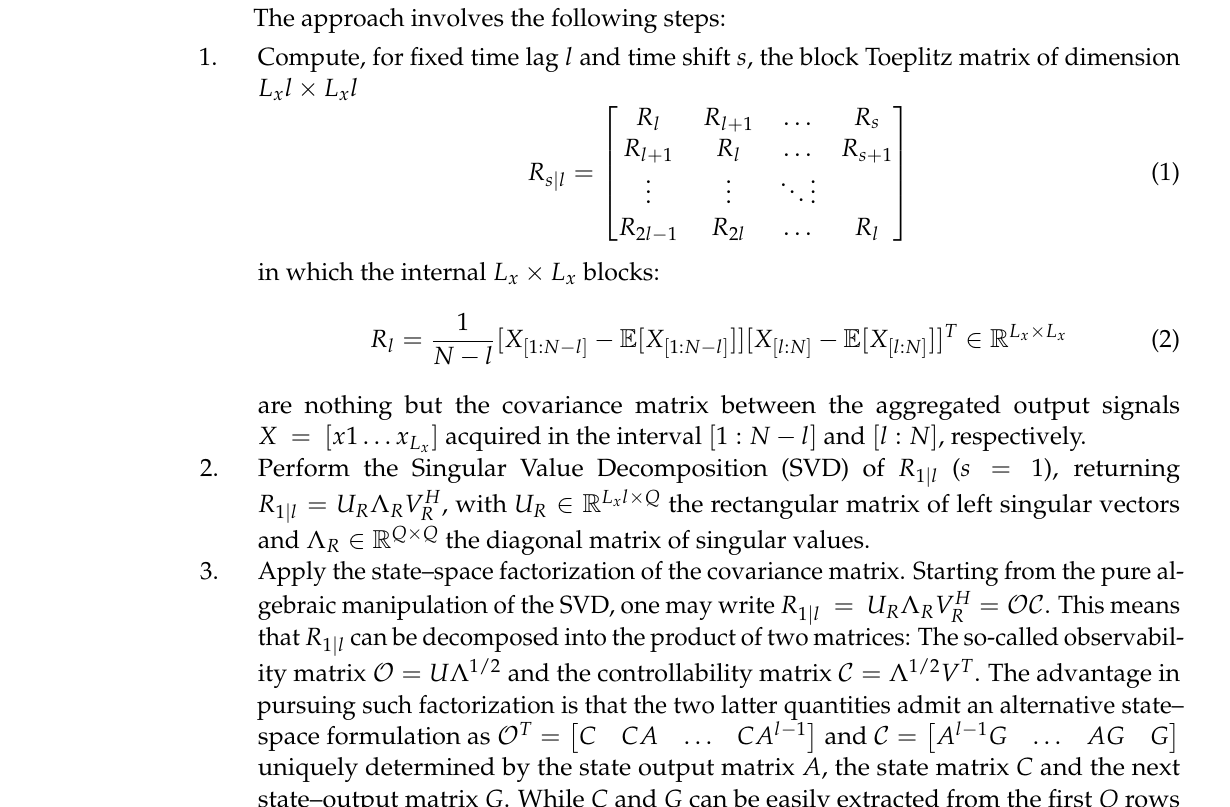
Figure 3. Schematic representation of the SSI-COV processing flow, from data collection to modal parameter